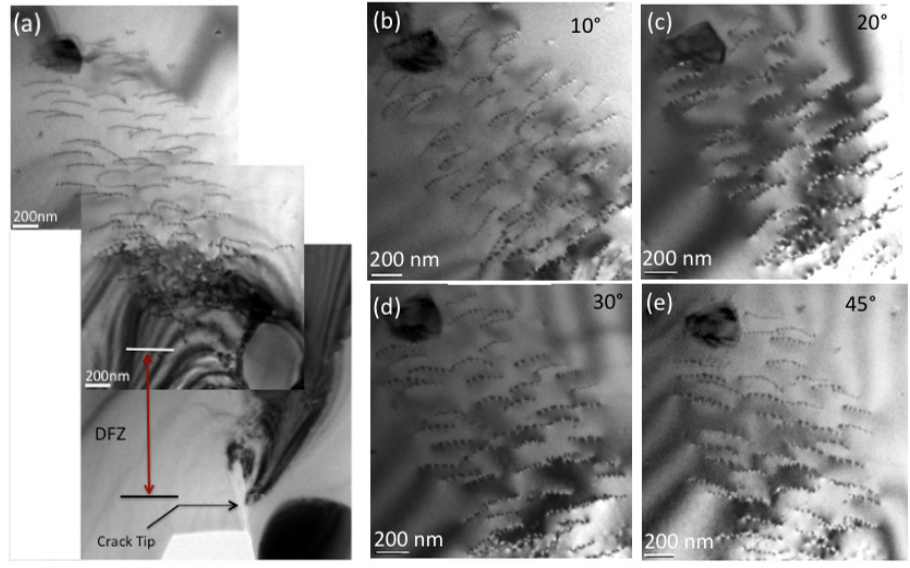
Figure 1. ( a , b ) A bright-field transmission electron microscopy (TEM) image close to the [111] zone in Cu showing curved dislocations ahead of a sharp crack